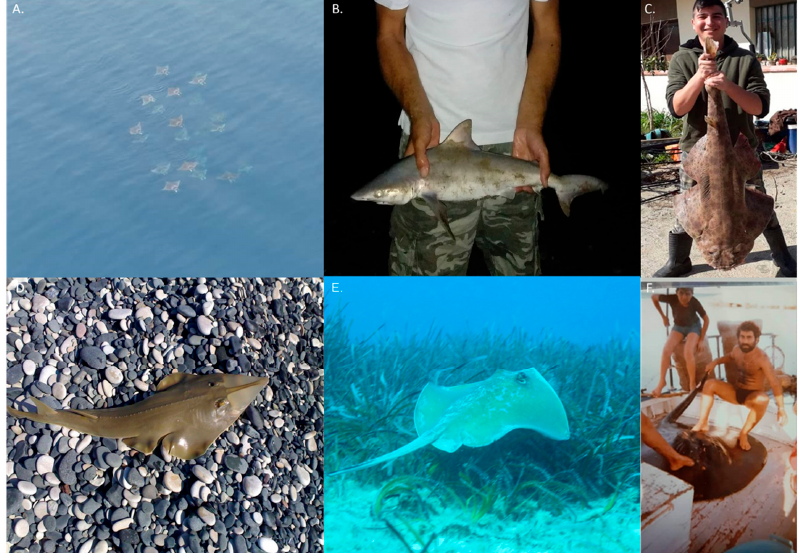
Figure 3. ( A ). Aggregation of Mobula mobular observed in 2020 in Cyprus. Photo credit: Marios Chisophorout. ( B ). A Carcharhinus plumbeus juvenile caught and released by a recreational fisher in 2018 in Cyprus. ( C ). A Squatina aculeata individual caught by a recreational fisher in 2020 in Cyprus. Photo credit: Stelios Kotzikas. ( D ). A female Glaucostegus cemiculus caught and released by a recreational fisher in 2010 in Cyprus. Photo Credit: Pampos Stavrou ( E ). A possible record of Dasyatis marmorata reported by Marine and Environmental Research Lab in 2020 from Cavo Greco, Cyprus. Photo Credit: Demetris Kleitou ( F ). A Taeniurops grabatus individual reported from a photo record that dates back in 1977 from Cyprus. Photo Credit: George Karamanos.